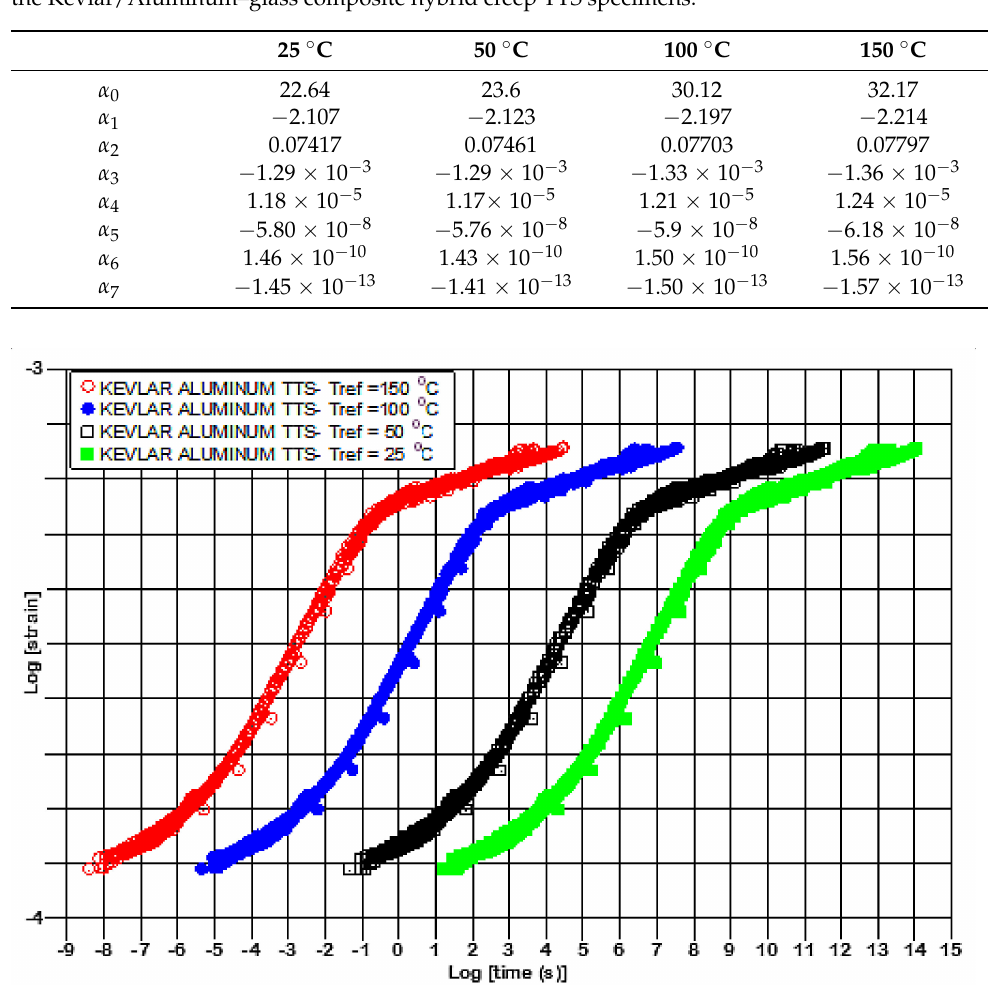
Figure 7. Kevlar/aluminum–glass composite hybrid, creep TTS master curves. The same procedure was repeated for the Vectran/Aluminum–glass composite hy- brids. The specimen creep response was obtained for different stress levels, as shown in Figure 8. Afterwards, the shift factors of the experimentally obtained curves were plotted, as seen in Figure 9. The sigmoidal behavior of the experimental TTS data for the curve shift factors disallows the application of the usual Arrhenius and WLF models, respectively. Again, a 7th-order polynomial equation (as in Equation (1)) was employed as shown in Figure 9. This approach delivered proper results with respect to the X-shift factor model- ing as a function of temperature. Practically, the 4th order was enough to approach the sigmoidal